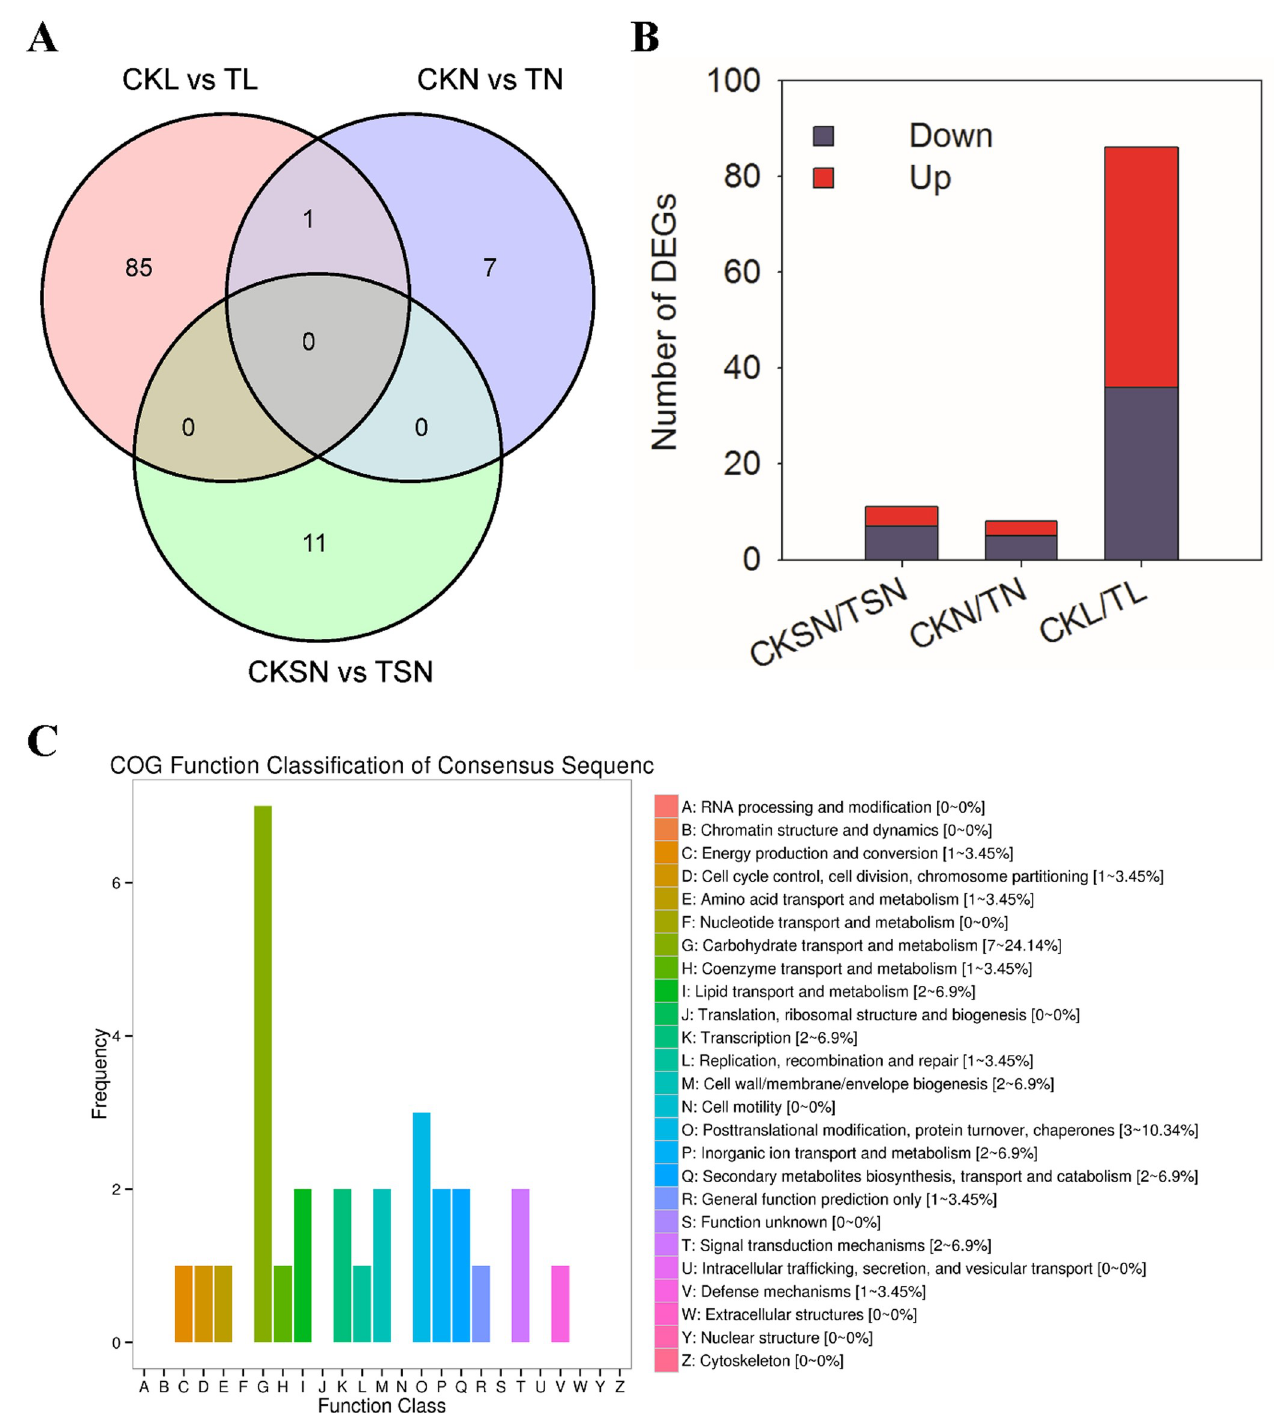
Fig 5. The differentially expressed genes (DEGs) between healthy bees and infested bees. A. The Venn diagram of differentially expressed genes between bees with and without olfactory learning ability in both the T . mercedesae -treated group and the CK group. B. the number of DEGs in each comparison. Up- regulated and down-regulated means that these genes were higher or lower expressed in infested group compared to CK group. C. COG Function Classification of DEGs in comparision CKL/TL.